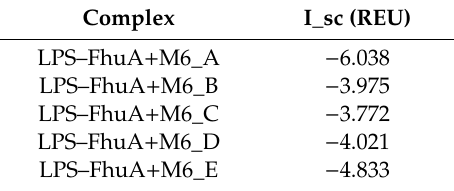
Table 4. Interface score of the selected complex in the global docking simulations for each peptide model.